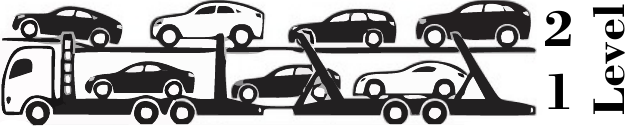
Figure 3. Auto-carrier levels.